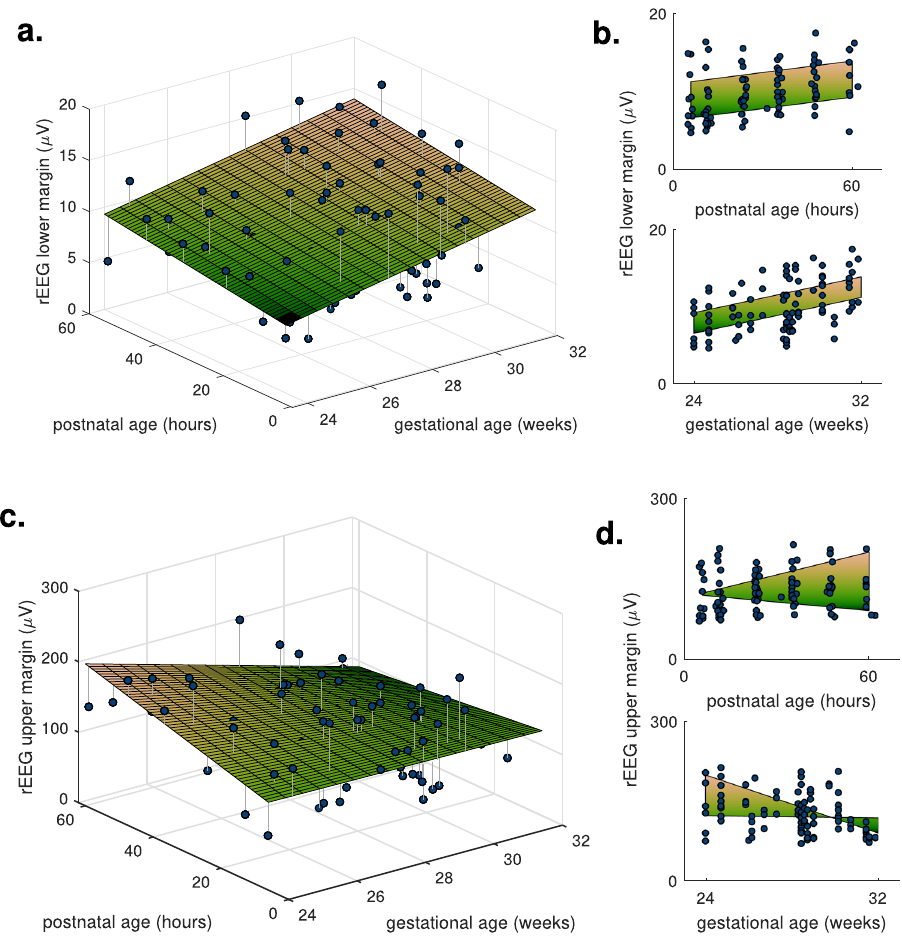
Figure 2. Two features of the rEEG, lower and upper margins, as dots with estimated fixed effects (2D planes). Features are dependent on both gestational age and postnatal age as the 2D plots in ( a , c ) illustrate this dependency; plots ( b , d ) show the marginal distribution, the side-view from either the x- or y-axis of the 2D plots in ( a , c ). The rEEG upper margin includes the postnatal age–by–gestational age fixed effect, resulting in a nonlinear 2D